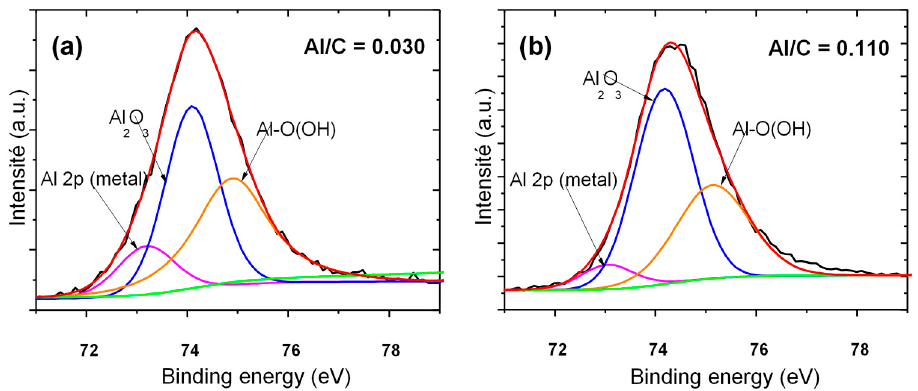
Figure 6. C1s XPS spectra of ( a ) undoped DLC and Al-DLC coatings: ( a ) Al/C = 0.030 and ( b ) Al/C = 0.110.